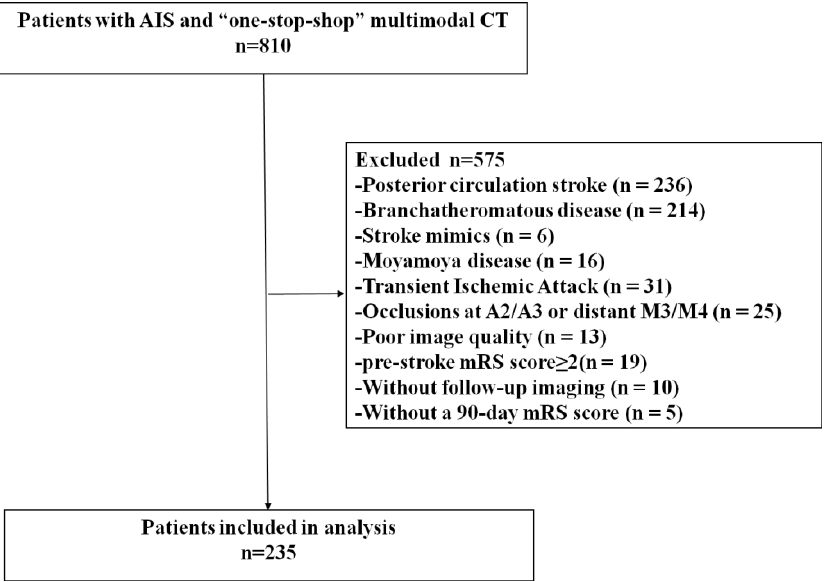
Figure 1. Flowchart of patient selection. AIS, acute ischemic stroke; mRS, modified Rankin scale. In brief, 810 patients with AIS who underwent ‘one-stop-shop’ multimodal CT ex- amination were reviewed from our database. Based on the inclusion/exclusion criteria, patients with posterior circulation stroke ( n = 236), stroke mimics ( n = 6), TIA ( n = 31), moyamoya diseases ( n = 16), anterior circulation branch-atheromatous diseases ( n = 214), occlusions of A2/A3 segment or distal M3/M4 segment of anterior cerebral artery ( n = 25), with poor image quality ( n = 13), a pre-stroke mRS score of 2 or greater ( n = 19), absent follow-up imaging ( n = 10), or absent 90 d mRS score ( n = 5) were successively excluded. Finally, for analysis, 235 eligible patients (median age, 66 years; interquartile range [IQR], 55.5–73 years; 178 males) were identified.